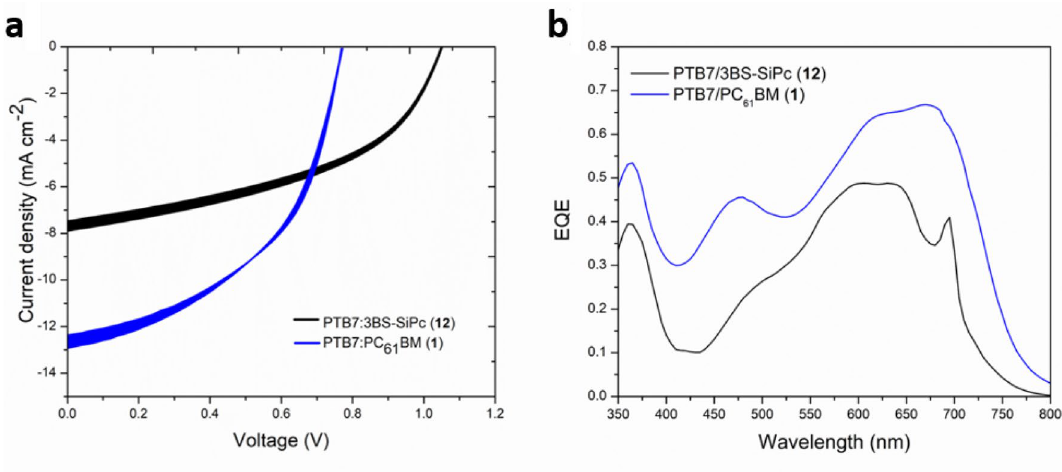
Figure 3. OPV characteristics ( a ) I–V curves, where line thickness corresponds to the standard deviation of 4 devices, and ( b ) EQE spectra of the optimized device ( 12 ) and the fullerene-containing baseline ( 1